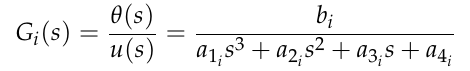
Table 2. Parameters of mathematical model for each joint.